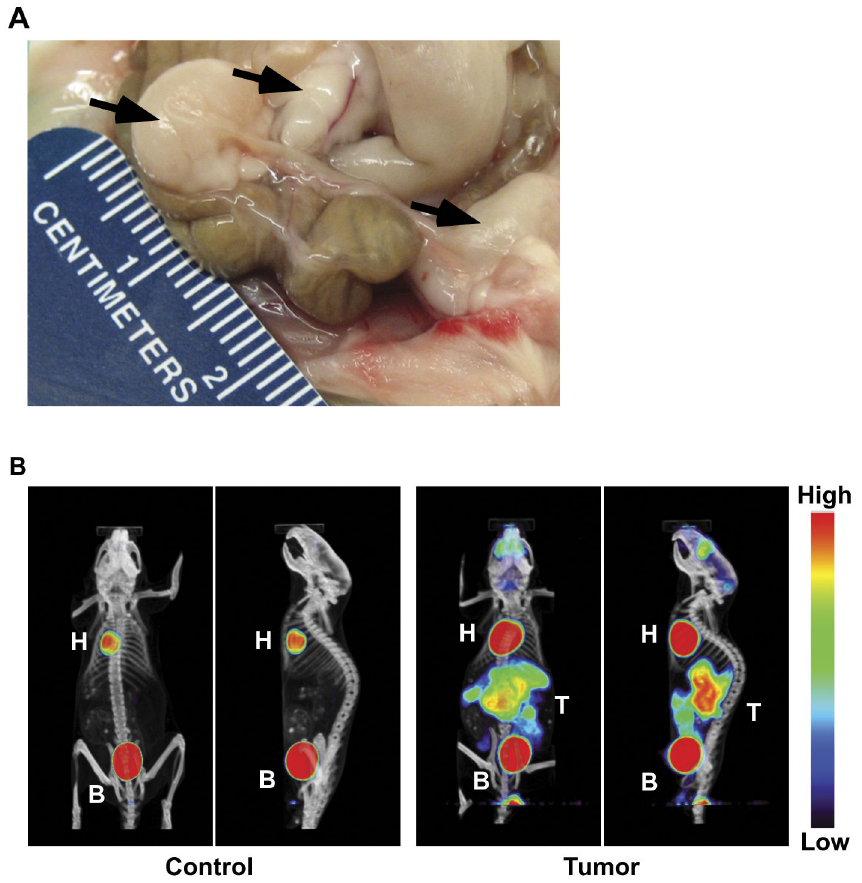
Figure 1. Images of 2F7-derived AIDS-Burkitt lymphoma (BL) tumors in NOD-SCID mice. ( A ) A picture showing three tumors growing in the peritoneal cavity, as indicated by arrows. The left tumor is located on an ovary; the middle tumor is in the mesentery, and the tumor to the right is under the abdominal wall. Brown areas are intestines. ( B ) PET images of a healthy control mouse that was not inoculated with tumor cells (left two panels), and of a mouse with advanced peritoneal tumors (right two panels). Animals were imaged 1 hour after i.v. injection of [ 18 F]-FDG. Coronal and sagittal images are shown. The color scale indicates the relative intensity of radioactivity levels, with black representing the lowest level and red the highest. H = heart; T = tumor masses; B =